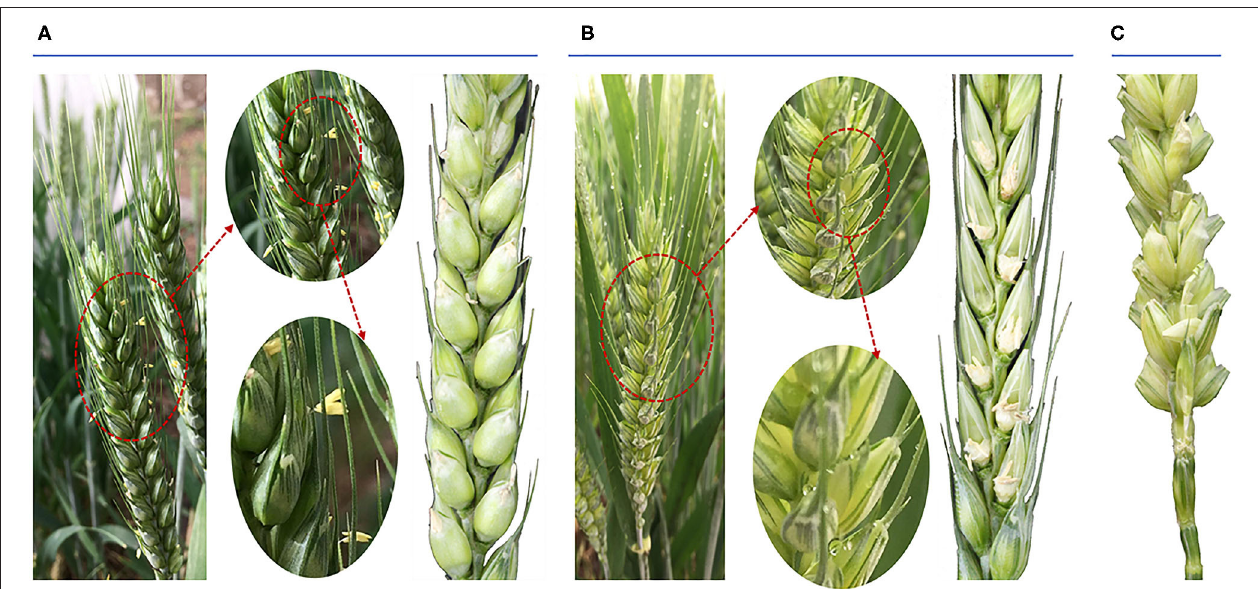
FIGURE 1 | Phenotypic traits of both the anthesis period of wheat ear and the seed status after wheat pollination. (A) The morphology of Normal anthers in anthesis on spikelets and the seed status. (B) The morphology of high temperature-male sterile (HT-ms) anthers in anthesis on spikelets and the seed status. (C) The seed status after artificial pollination of HT-ms